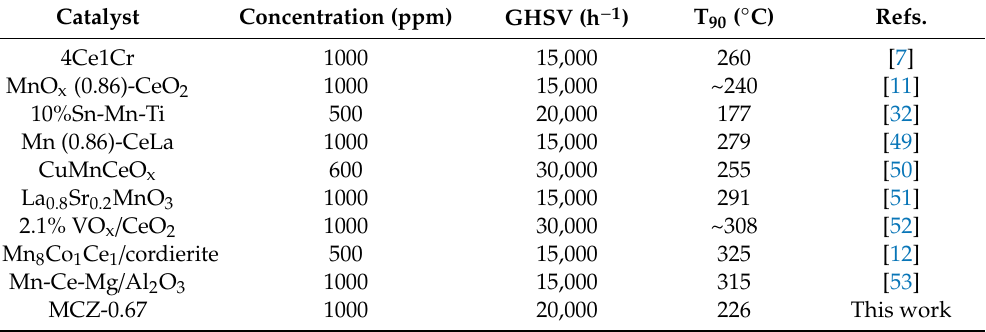
Table 4. Main data of literature reports on CB elimination over transition metal oxide